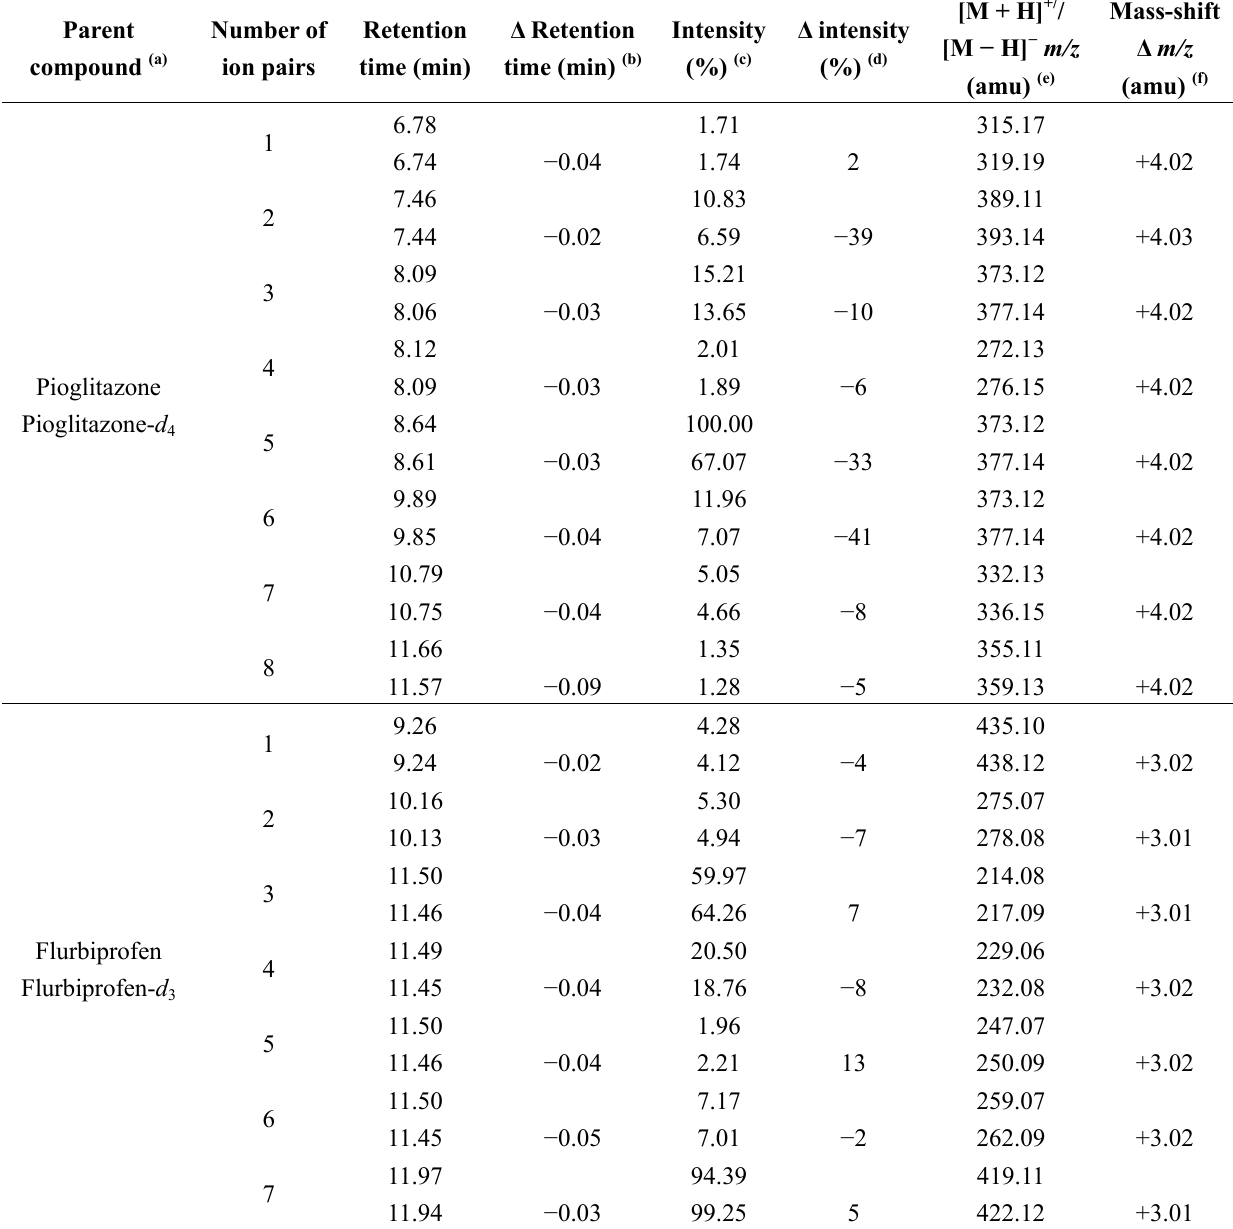
Table 1. Ions detected by stable isotope mass-shift filtering between deuterium-labeled and un-labeled compounds in pioglitazone and flurbiprofen metabolized in human liver